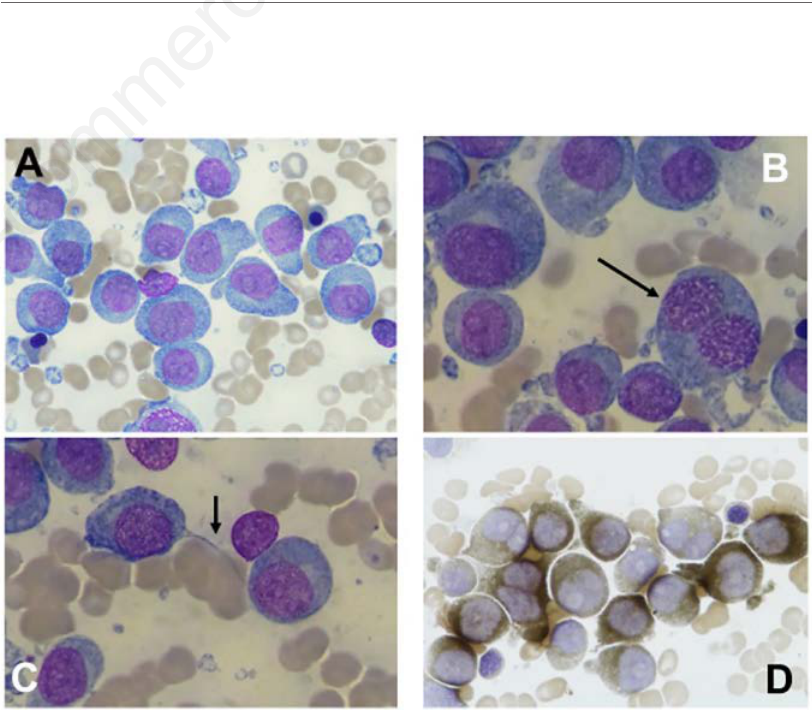
Figure 1. Morphology of circulating blast cells (May-Grünwald-Giemsa; x1,000).